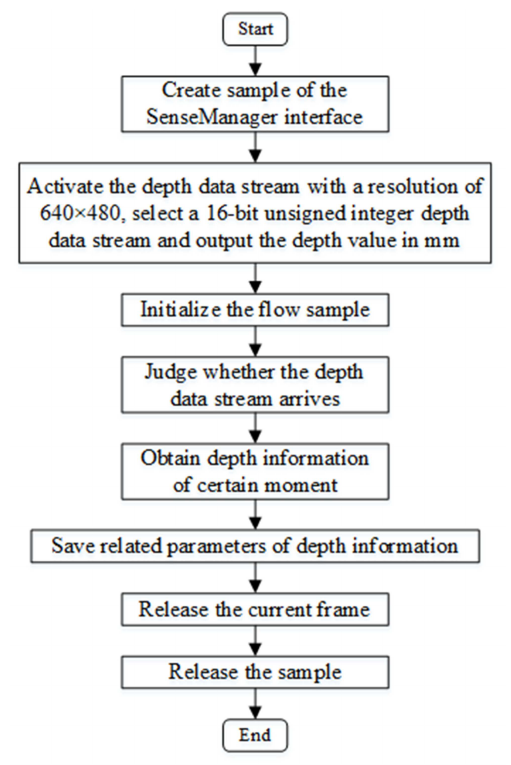
Figure 3. The algorithm flow of the acquisition of depth information with RealSense.